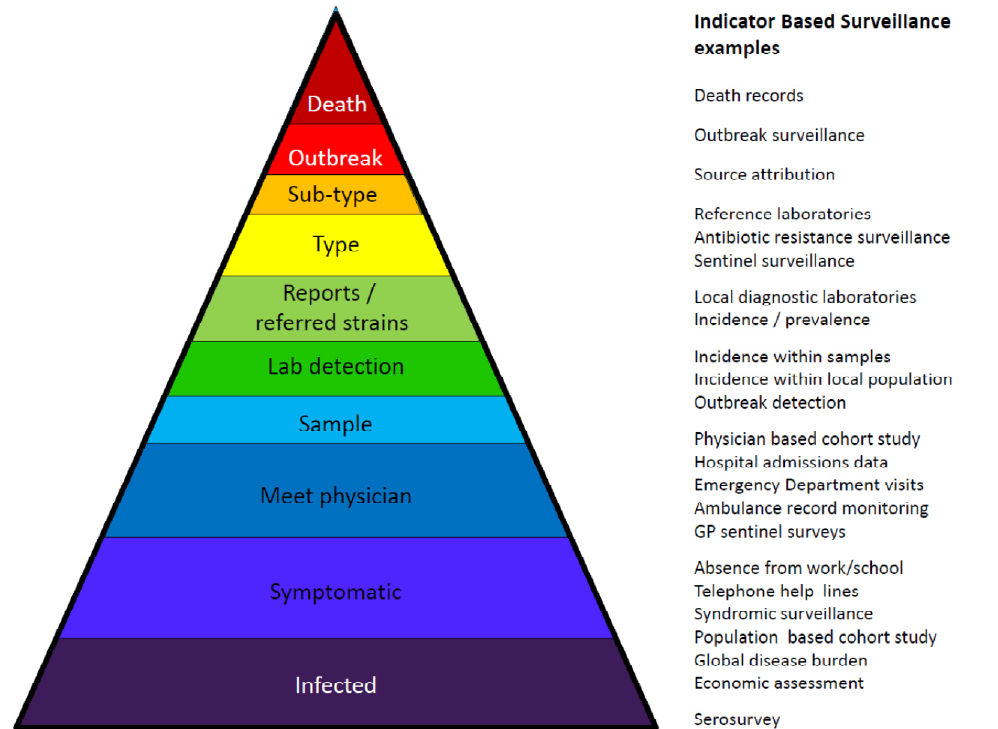
Figure 1. Surveillance pyramid and examples of the surveillance systems used to assess different parts of the pyramid *